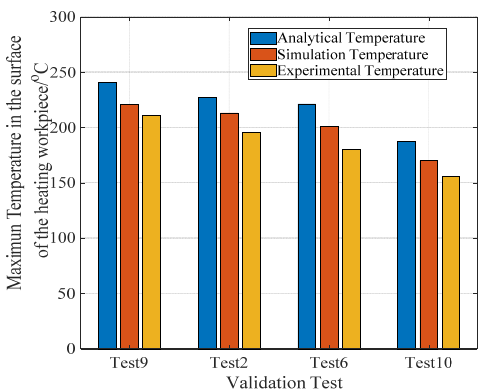
Figure 16. Maximum temperature validation in the surface of the workpiece ( v = 8 mm/s).